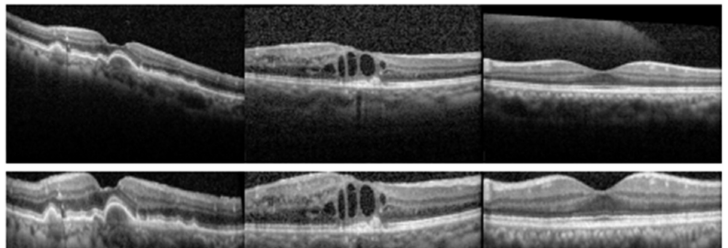
Figure 5. Beijing clinical small-scale dataset. First row shows original AMD, DME and normal optical coherence tomography (OCT) images. Second row shows AMD, DME and normal OCT images after